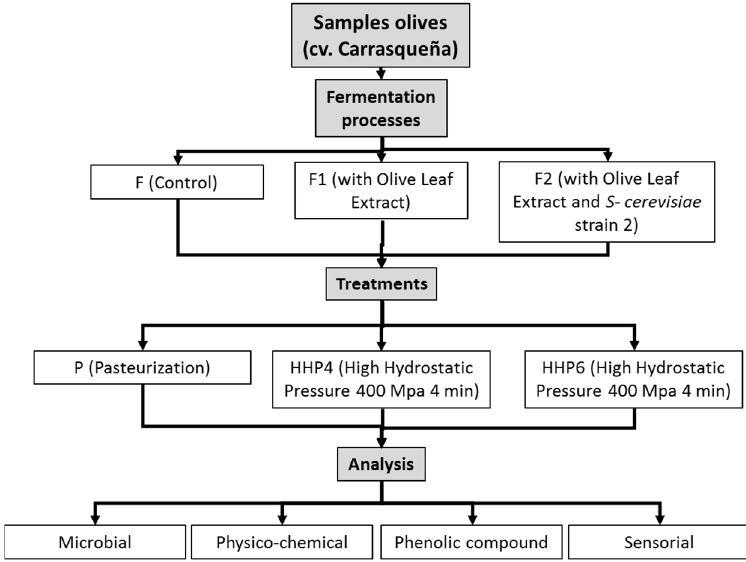
Figure 4. Diagram of the experimental design.